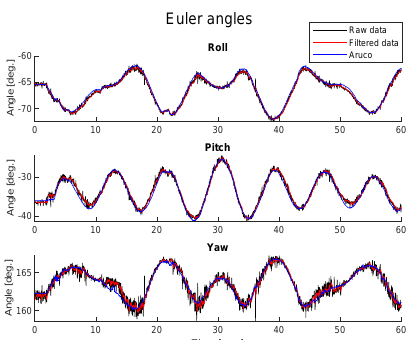
Figure 8: The plots show the measured, estimated and true Euler angles of the rotation matrices which represent the relative attitude between the sensor frame and the observed plane.